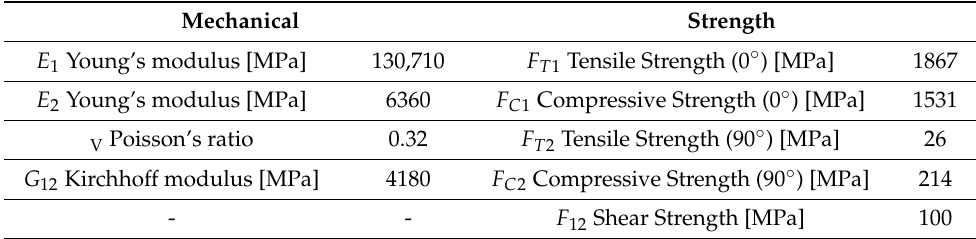
Table 1. The composite material properties.